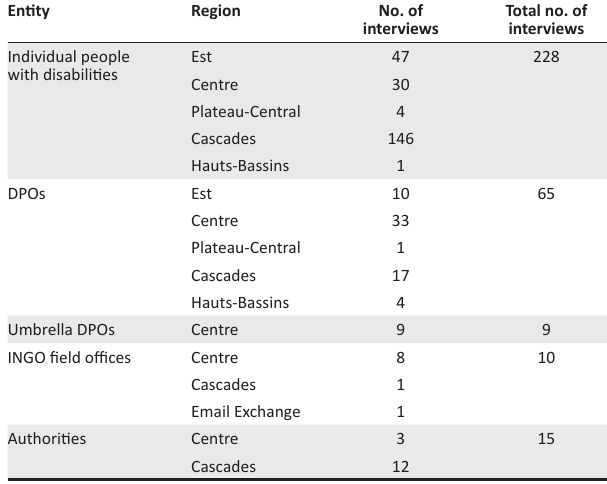
TABLE 1: Interviews held in Burkina